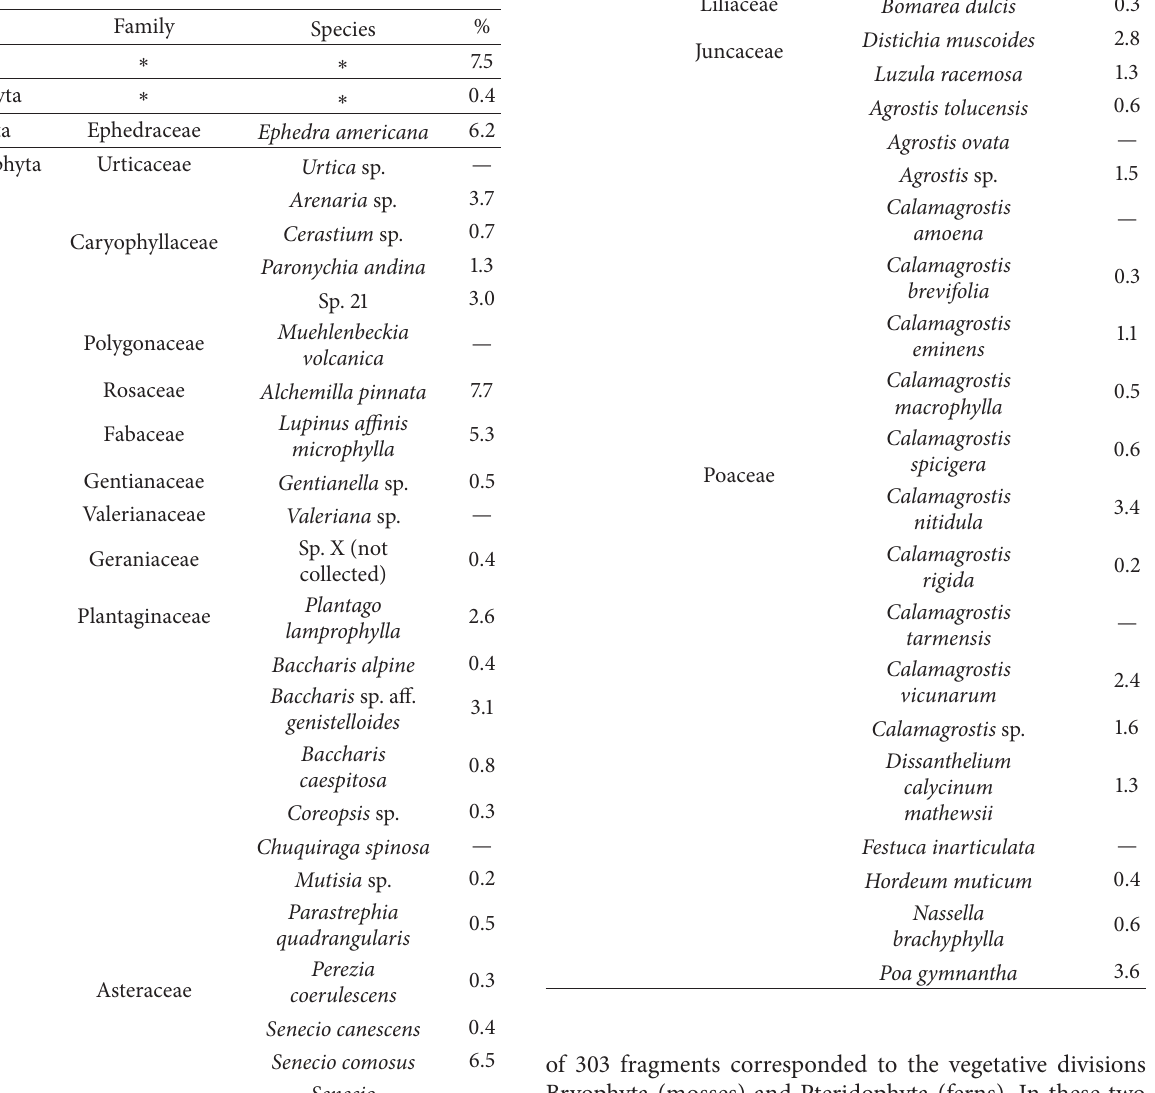
Table 1: Plant species collected and percentage (from the total iden- tified) of fragments of the species most often detected as consumed by taruca in the dry